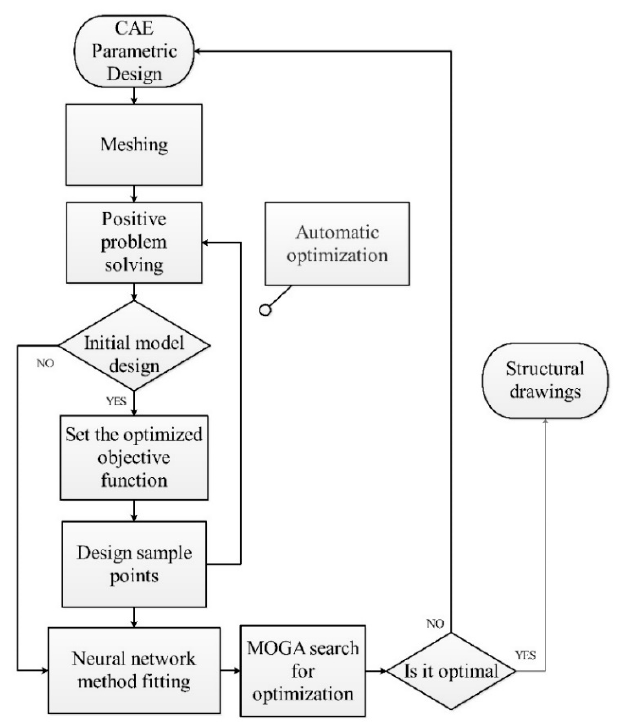
Figure 10. Flow diagram of MOGA optimization for the snowflake flow channel fuel cells.